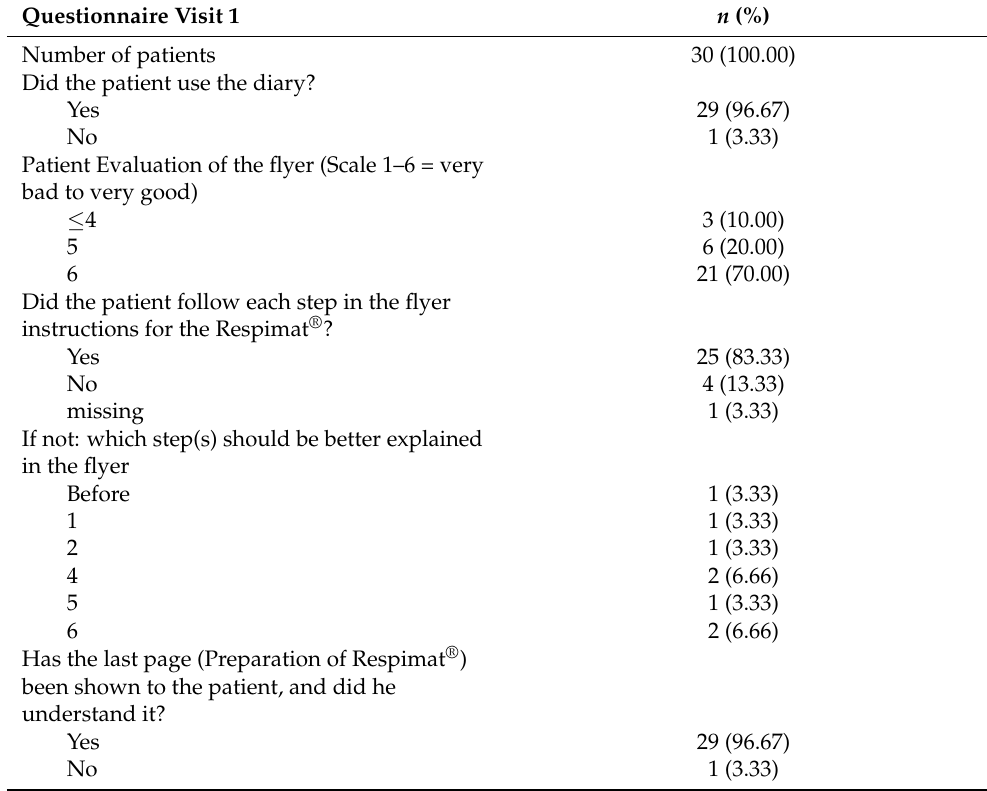
Table 2. Questionnaire at visit